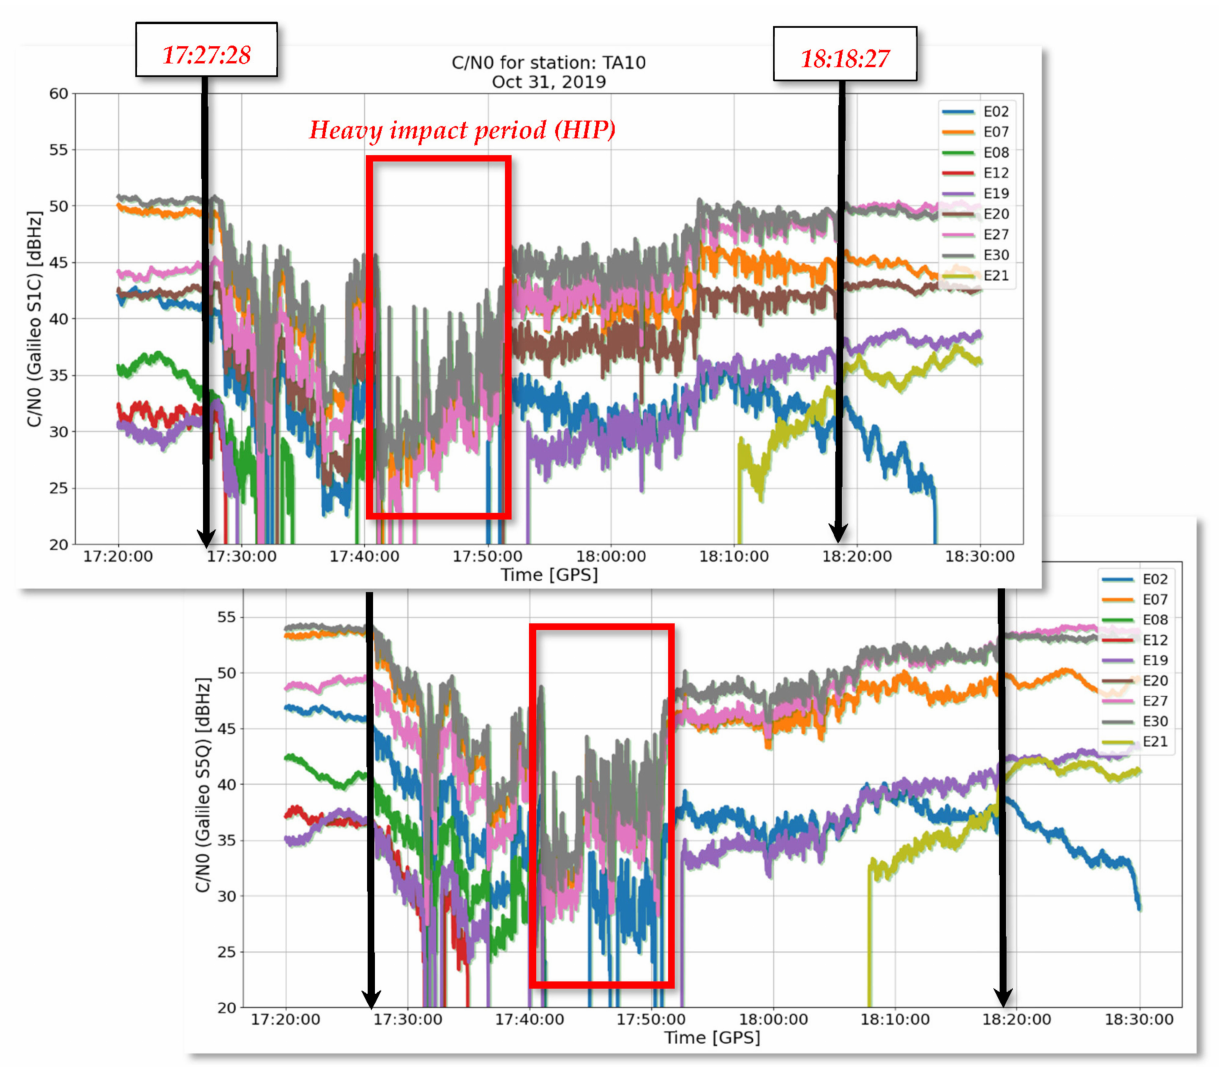
Figure 5. C/N 0 values for Case 2; a multifrequency jamming incident registered at TA10. Figures show Galileo E1 and E5a measurements, but all frequencies are equally affected. The black arrows mark the beginning and ending of the incident. In the period around 17:40–17:50, the receiver is most heavily affected, losing track of several